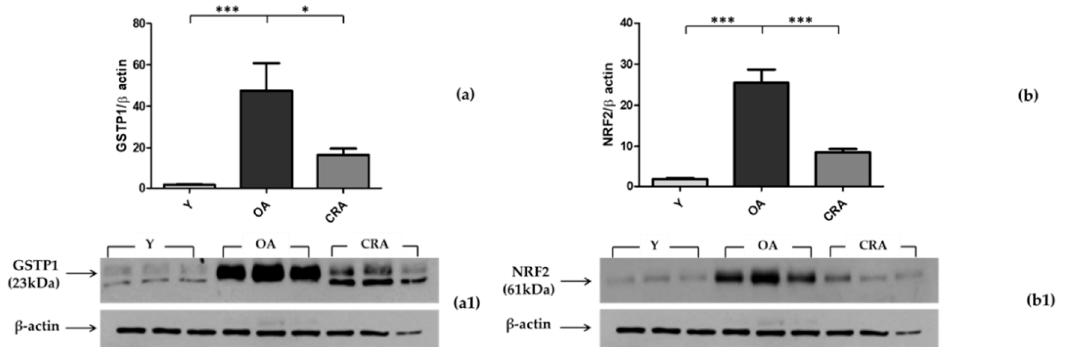
Figure 5. Western blotting of GSTP1( a ) and NRF2( b ) in adipose tissue samples of Y, OA, and CRA rats; ( a1 , b1 ) show the densitometric quantification of the blots. Protein loading was verified by using the anti- β -actin antibody. Data are means ± SE of five determinations for each animal ( n = 6). Statistical differences were evaluated by one-way ANOVA, followed by Bonferroni’s multiple comparison test (* p < 0.05; *** p < 0.0001).